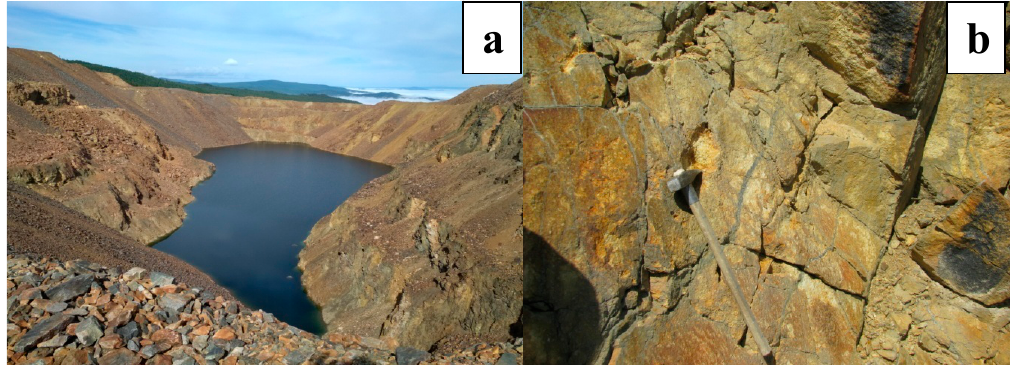
Figure 1. ( a ) Abandoned quarry at the Pervomaiskoe deposit; ( b ) quartz-molybdenite veinlets in the Pervomaisky stock granites.